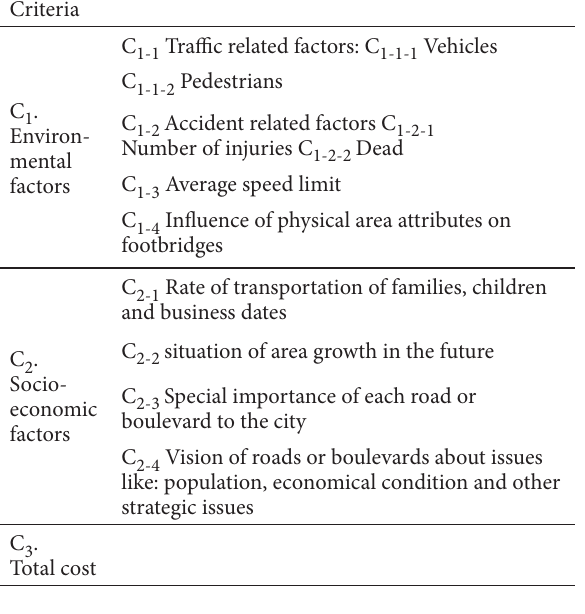
Table 3. Criteria, sub-criteria, sub-sub criteria and their descriptions